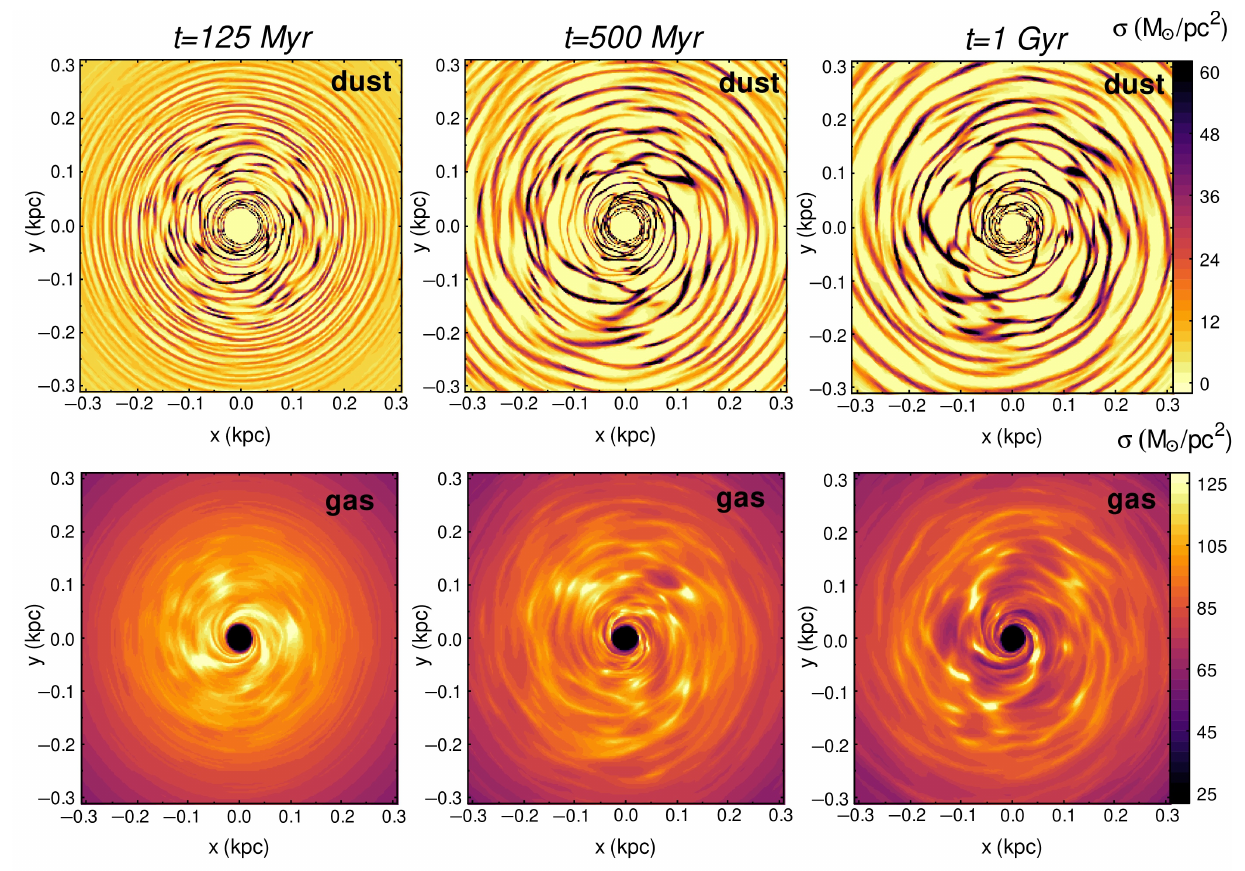
Figure 3. Snapshots of the temporal evolution of dust (upper row) and gas (lower row) surface densities in the reference model M233 taken at times t = 125 Myr, t = 500 Myr, and t = 1 Gyr (from left to right). Surface density is measured in [ M (cid:12) pc − 2 ]). The instability of the gaseous dusty disk results in the development of the nonlinear multi-armed spiral structure.